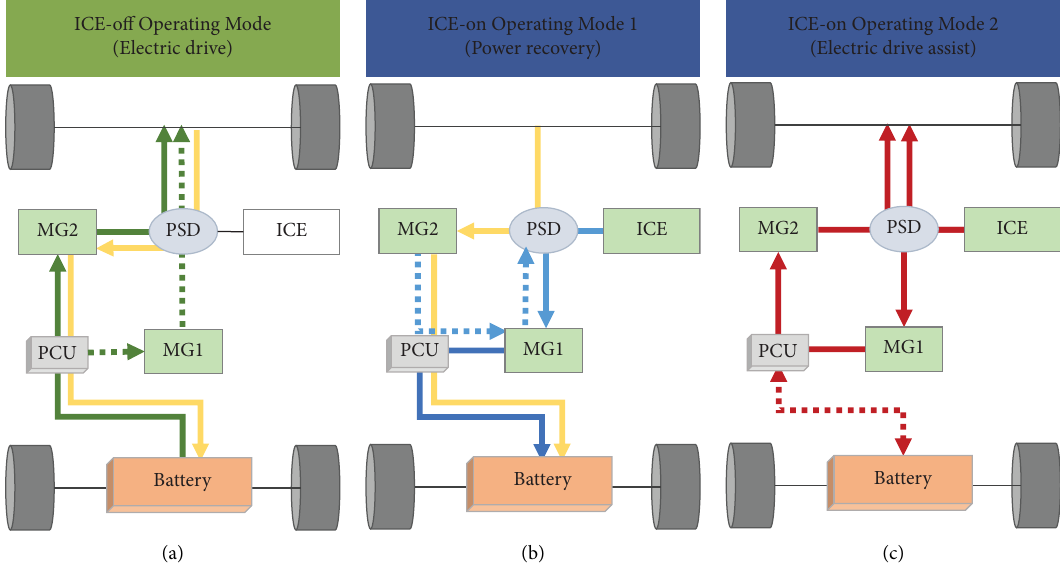
Figure 2: HEV power fow for diferent ICE operation